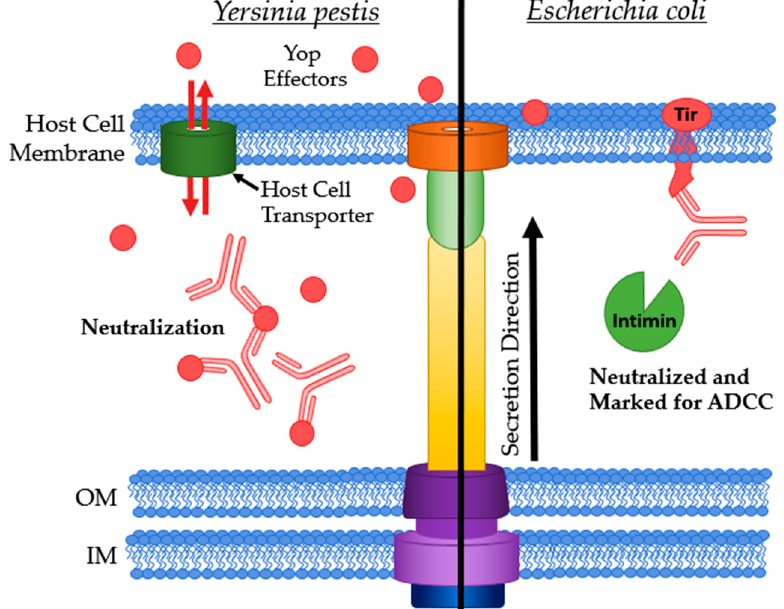
Figure 7. Antibodies targeting extracellularly available effector proteins. Left : Yop effectors being neutralized when in the extracellular matrix. Right : Ab bound to Tir marking the host cell for ADCC and neutralizing Tir by preventing intimin binding. IM: bacterial inner membrane; OM: bacterial outer membrane.